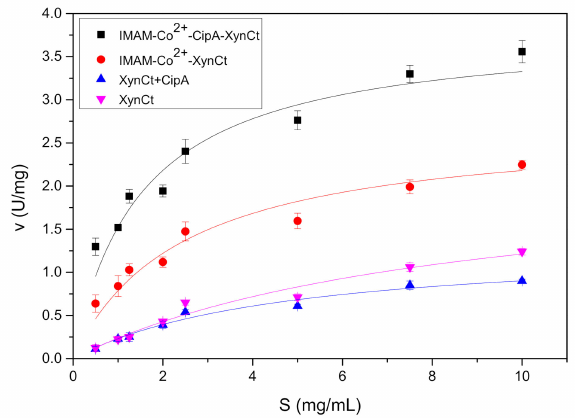
Figure 7. Michaelis–Menten plots of various immobilized and free enzymes. Symbols represent experimental data and lines represent regression results. The error bars represent SD, n = 3. Table 1. Kinetic parameters of various types of enzymes.